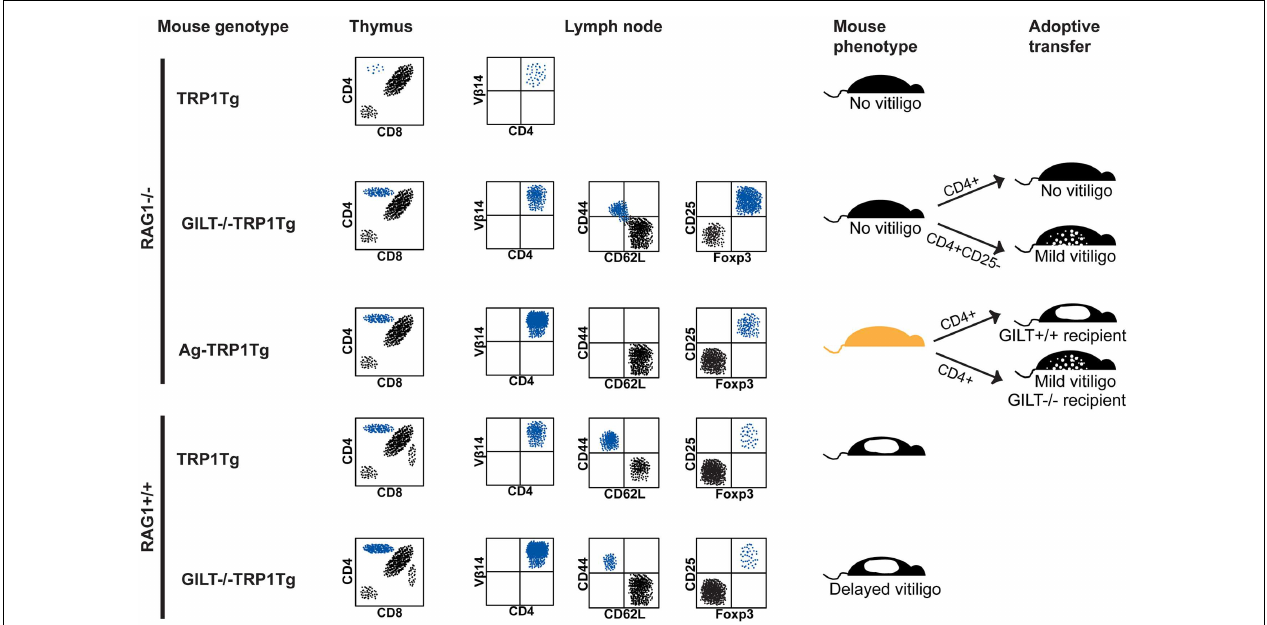
FIGURE 1 | GILT in tolerance and autoimmunity . Schematic representation of flow cytometry, phenotype, and adoptive transfer results in theTRP1Tg mouse strains. Staining of thymocytes is shown in a forward scatter and side scatter gate with dead cell exclusion. Staining of lymph node cells is shown gated onV β 14 + CD4 + TRP1-specificT cells. (From top to bottom) in RAG1 − / − TRP1Tg mice,TRP1-specificT cells undergo thymic deletion (24).